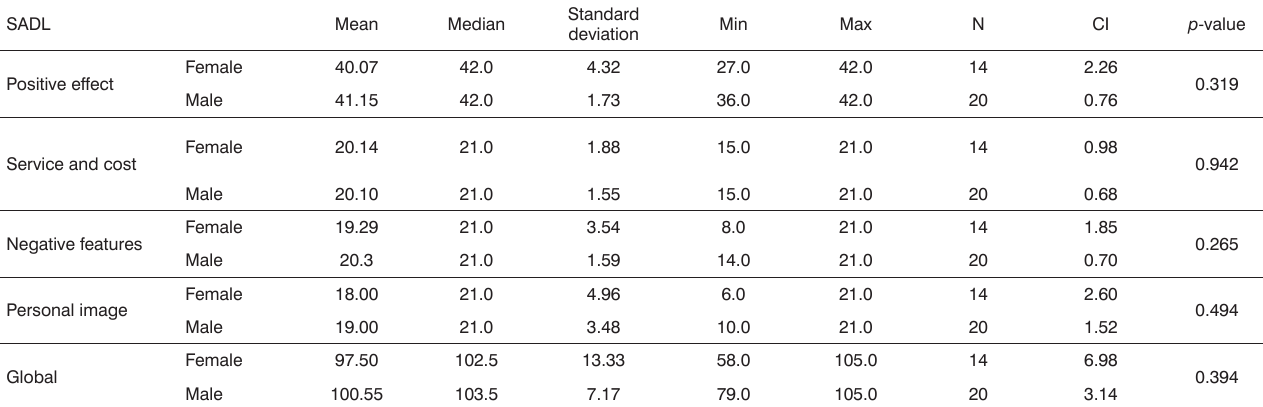
Table 5. Comparison between global and subscale scores for